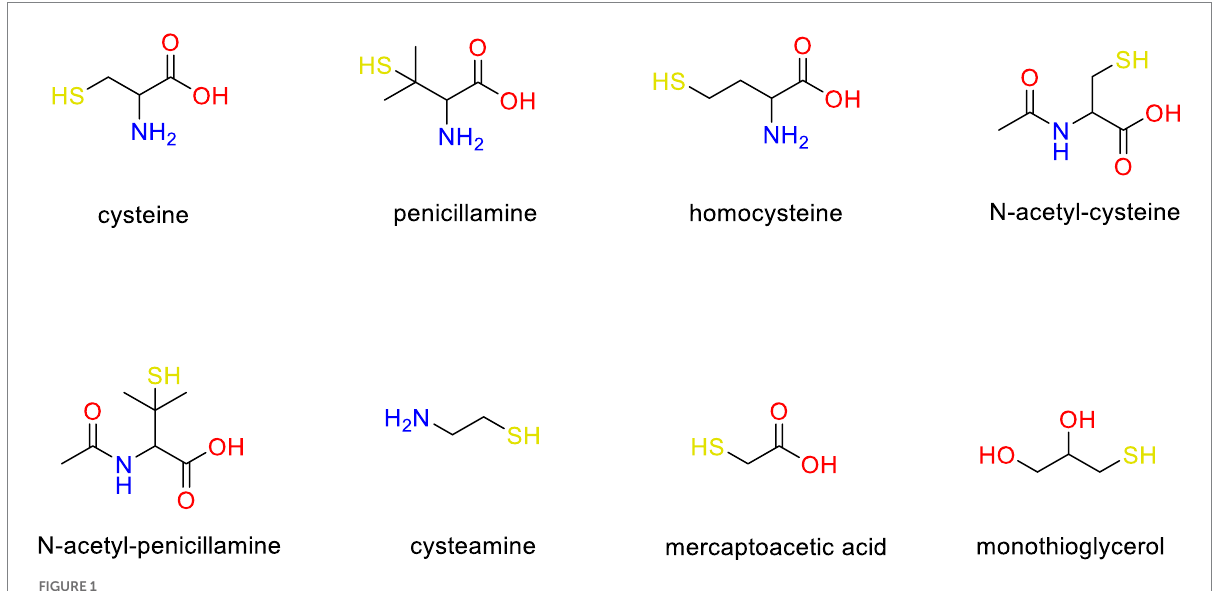
FIGURE 1 Chemical structure of the LMM thiol compounds included in this